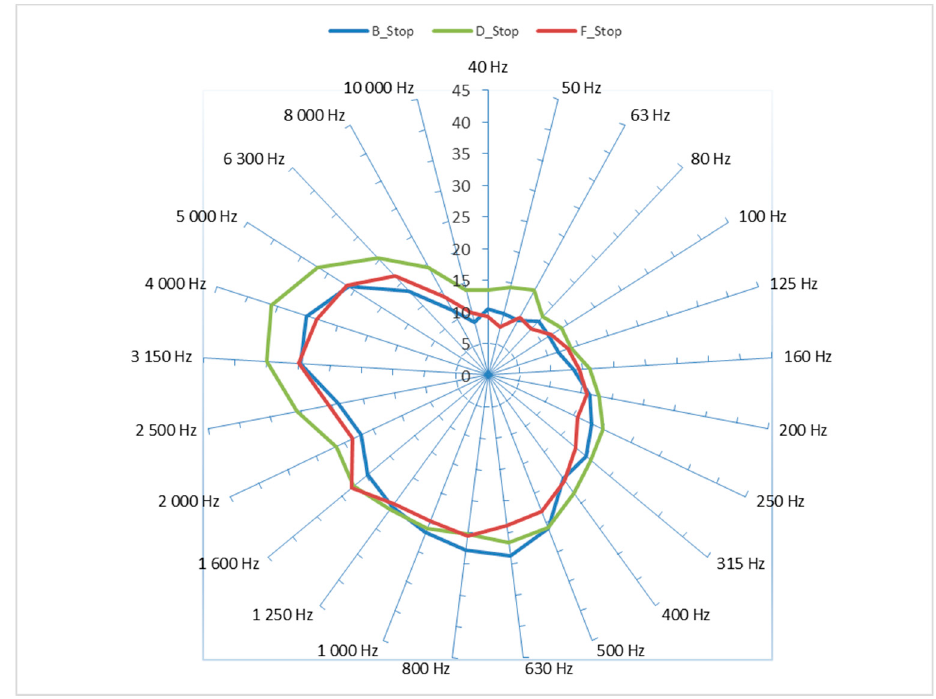
Figure 11. Values of noise emissions measured in residential areas out of operation (Stop).